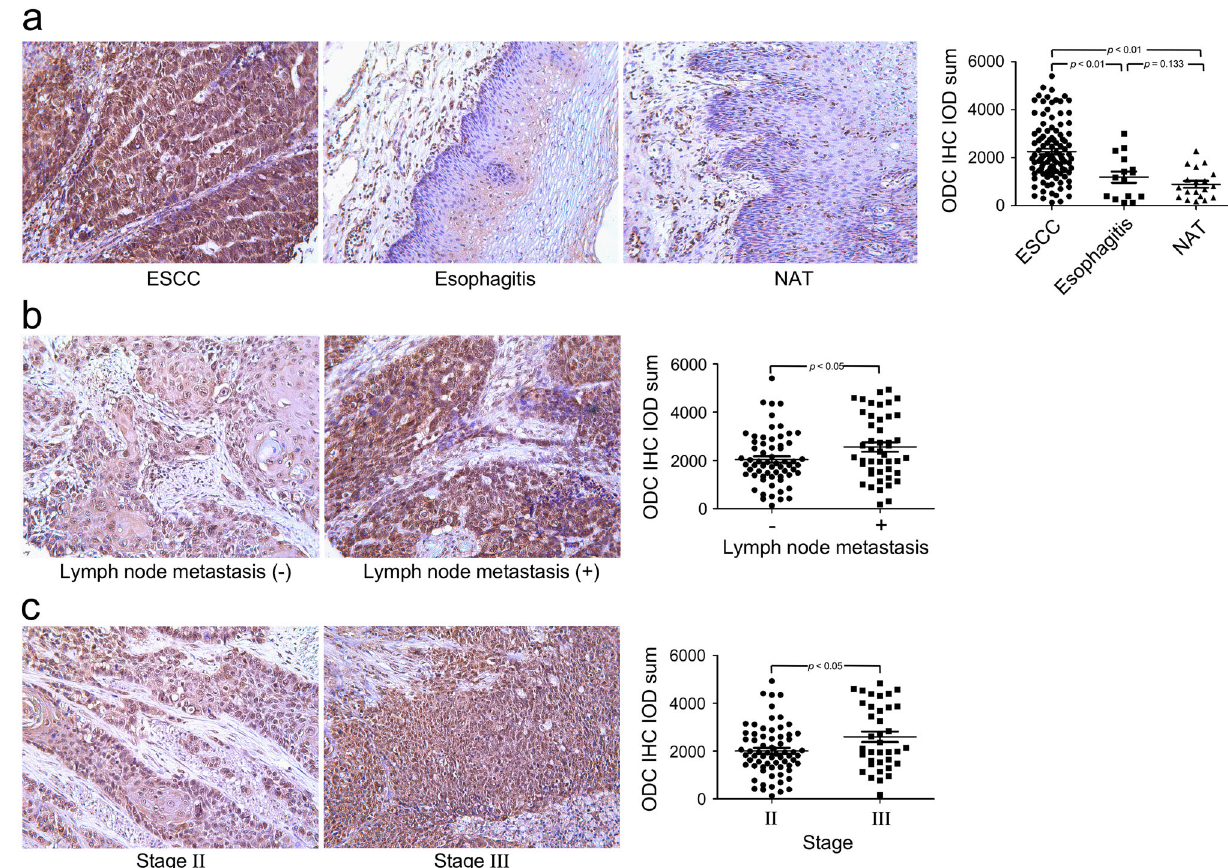
Fig. 1 ODC expression is up-regulated in ESCC. a The ODC immunohistochemical IOD value is signi fi cantly higher in ESCC compared to esophagitis or NAT. The ODC protein expression level in ESCC is signi fi cantly correlated with b status of lymph node metastasis and c clinical stage. Signi fi cant differences were determined using the Student ’ s t